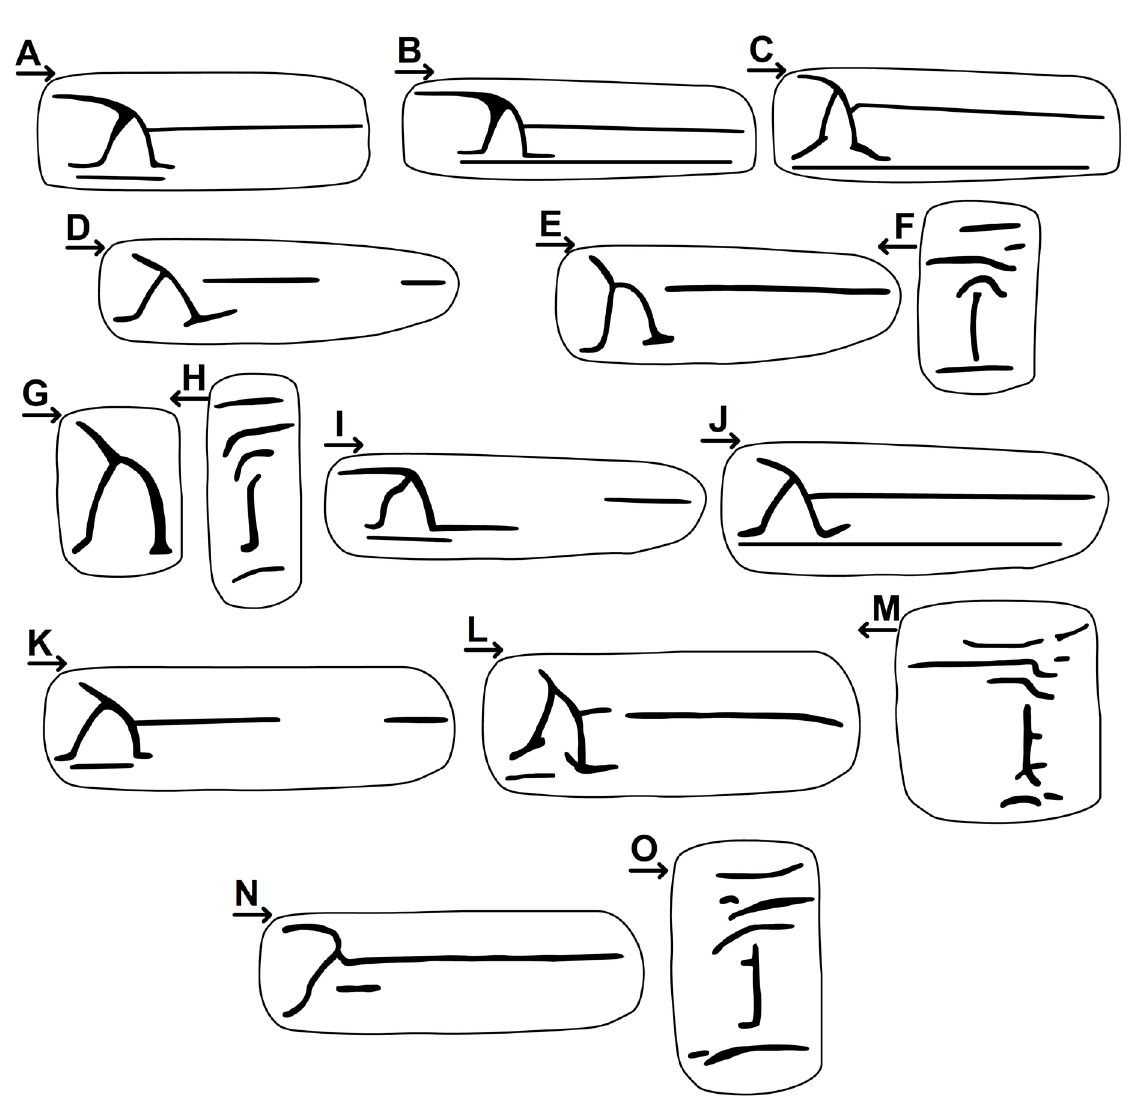
Fig. 35. Parietal (A–E, G, I–L, N) and palatal (F, H, M, O) plication of species of Plectopylis Benson, 1860. A . P. anguina Gould, 1847, paralectotype (NHMUK 20140812). B . P. repercussa Gould, 1856, lectotype (MCZ 169336). C . P. bensoni var. repercussoides Gude, 1899, holotype (NHMUK 1922.8.29.46). D . P. cairnsi Gude, 1898, holotype (NHMUK 1922.8.29.47). E–F . P. cairnsi (UF 76761). G–H . P. crassilabris sp. nov., paratype (UF 448577). I . P. cyclaspis Benson, 1859 (NHMUK 1906.02.02.148). J . P. karenorum (W. Blanford, 1865) from “Pegu”, Myanmar (NHMUK). K . P. linterae var. fusca Gude, 1898 (NHMUK 1888.12.04.1541–3). L–M . P. malayana sp. nov., paratypes from the type locality (coll PGB). N–O . P. thompsoni sp. nov., paratype (UF 448578). Arrows below the letters indicate the direction of the aperture. Not to